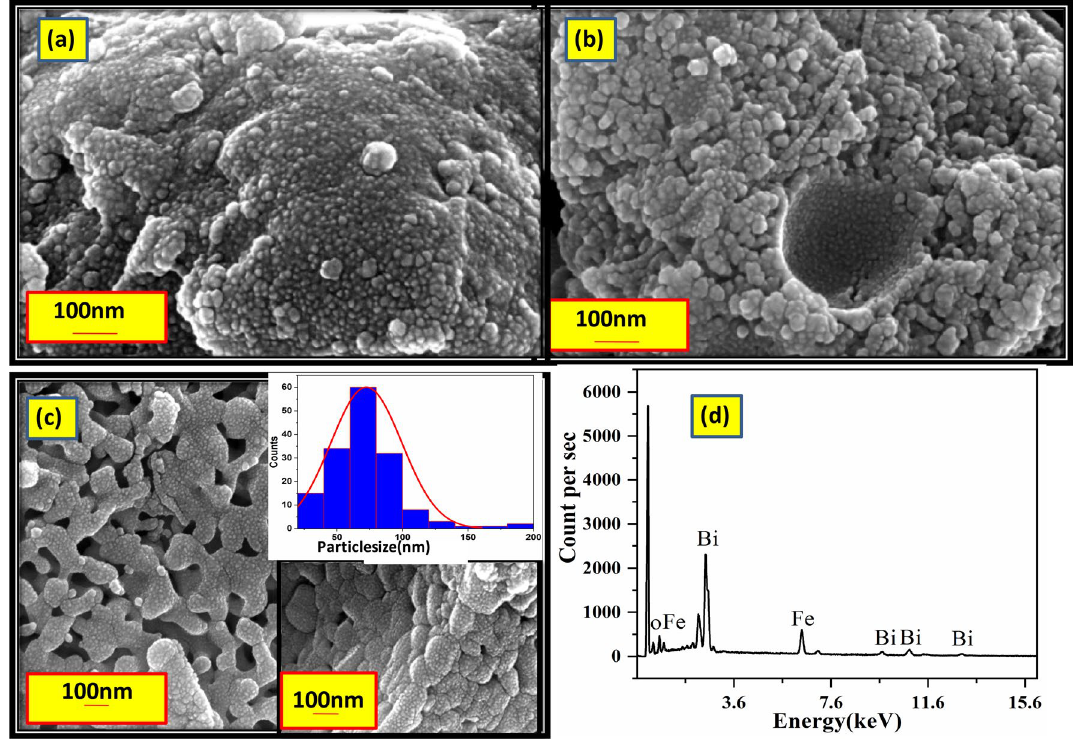
Figure 2. SEM images of the precursor annealed at ( a ) 573 K 2 h, ( b ) 673 K 2 h, ( c ) 773 K 2 h. Shown in inset of ( c ) are the SEM micrographs taken with low and high magnification along with the result of the particle size distribution analysis showing that the mean particle size is around 70 nm. While the EDAX spectrum (Cf. d ) obtained in the precursor annealed at 773 K shows the peaks corresponding to Bi and Fe showing that the atomic ratio of Bi and Fe as